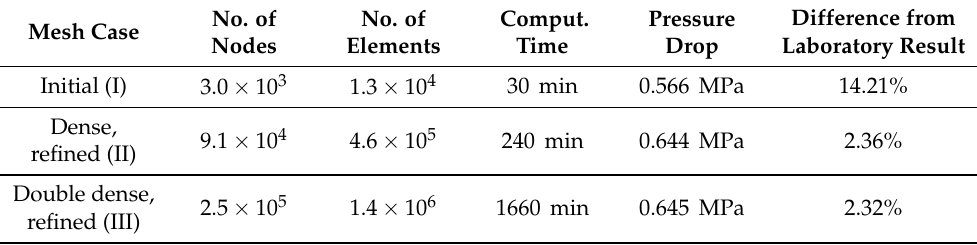
Table 3. Mesh quality